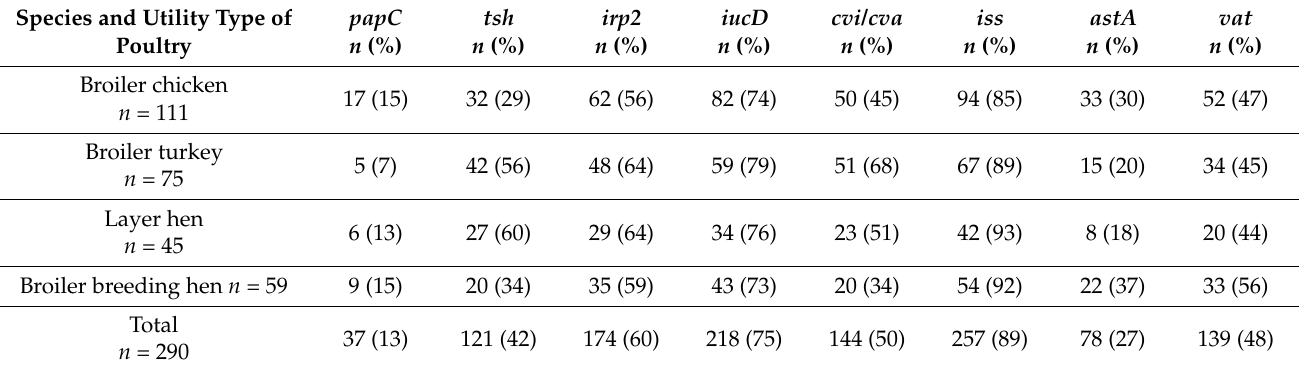
Table 4. Results of analysis of the presence of virulence genes in all tested E. coli